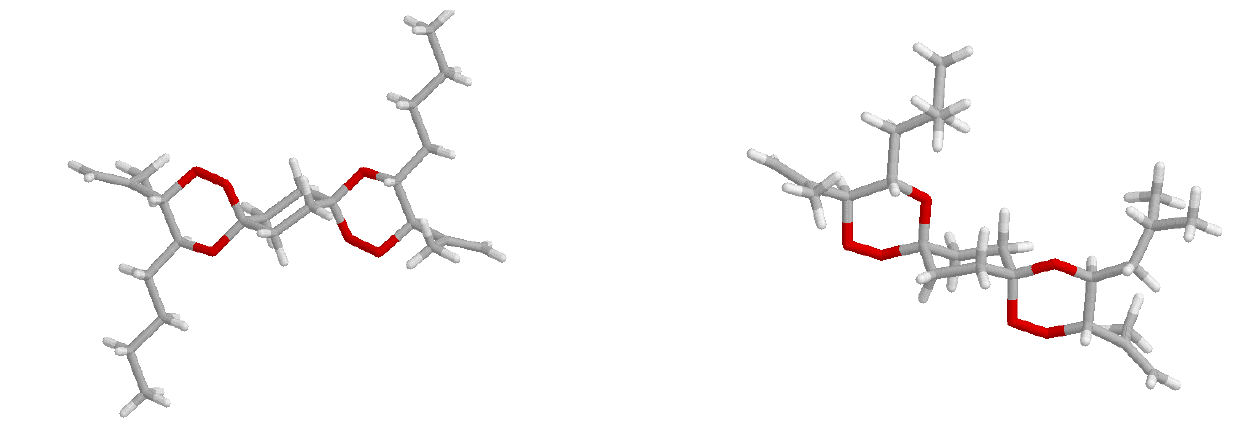
Figure 1. X-ray structure of anti - 4a and syn - 4d